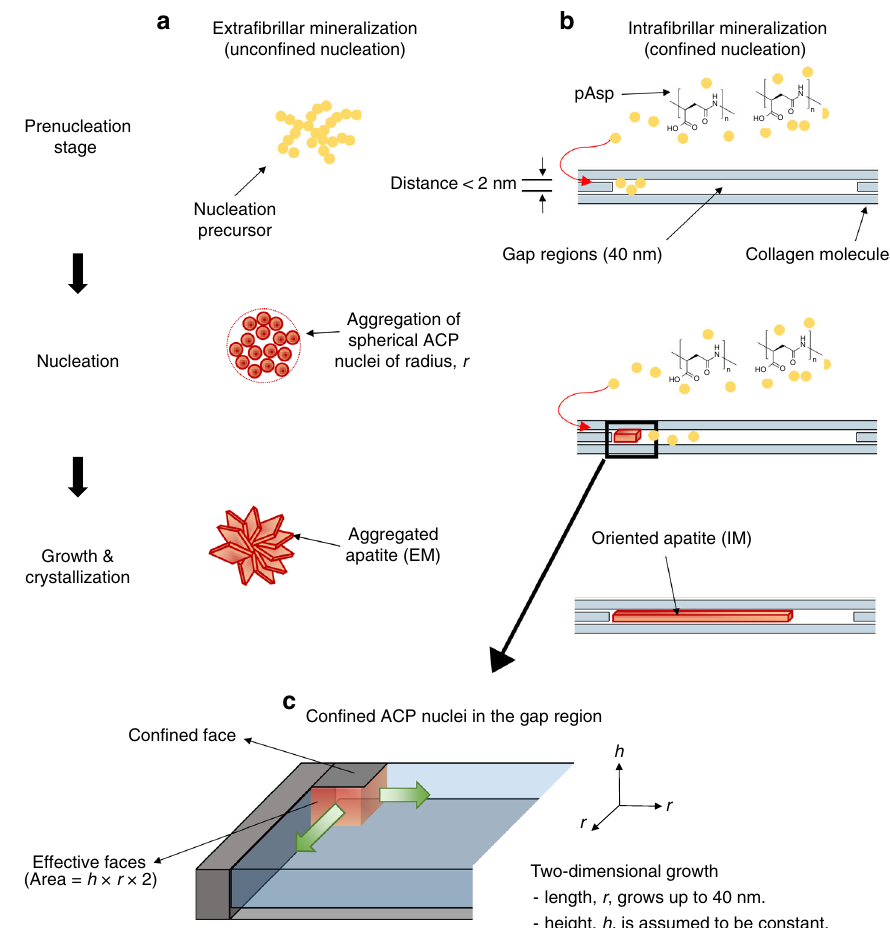
Fig. 1 Schematic illustration of two different nucleation models for collagen mineralization. a Extra fi brillar nucleation in uncon fi ned space and b intra fi brillar nucleation in a con fi ned gap region. c Geometry of con fi ned amorphous calcium phosphate (ACP) nuclei in the gap